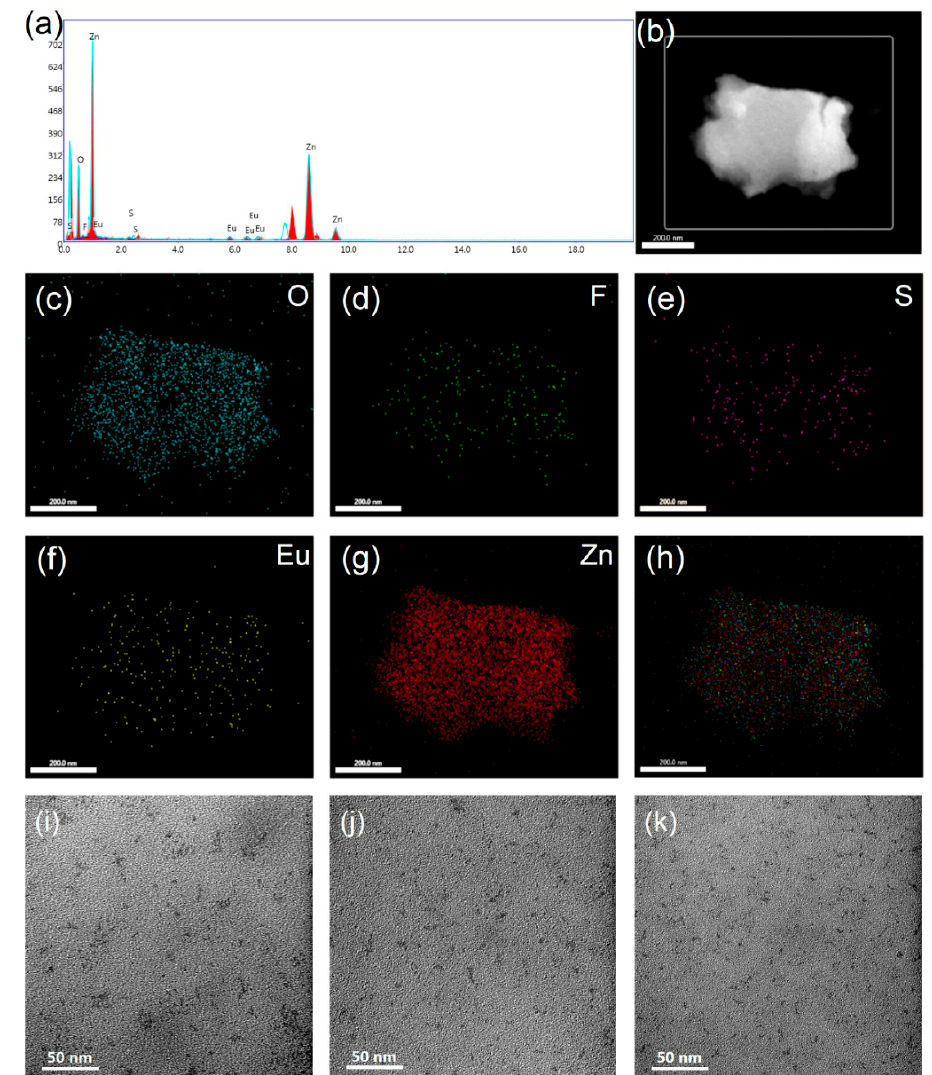
Figure 5. ( a ) The corresponding EDS spectra of ZnO/ETP film; HR-TEM image of ( b ) ZnO/ETP film scraping from a glass substrate and ( c – g ) the corresponding elemental mappings of O, F, S, Eu, and Zn, respectively; and ( i – k ) TEM images of ETP1, ETP2, and ETP3 precursor solution, respectively.